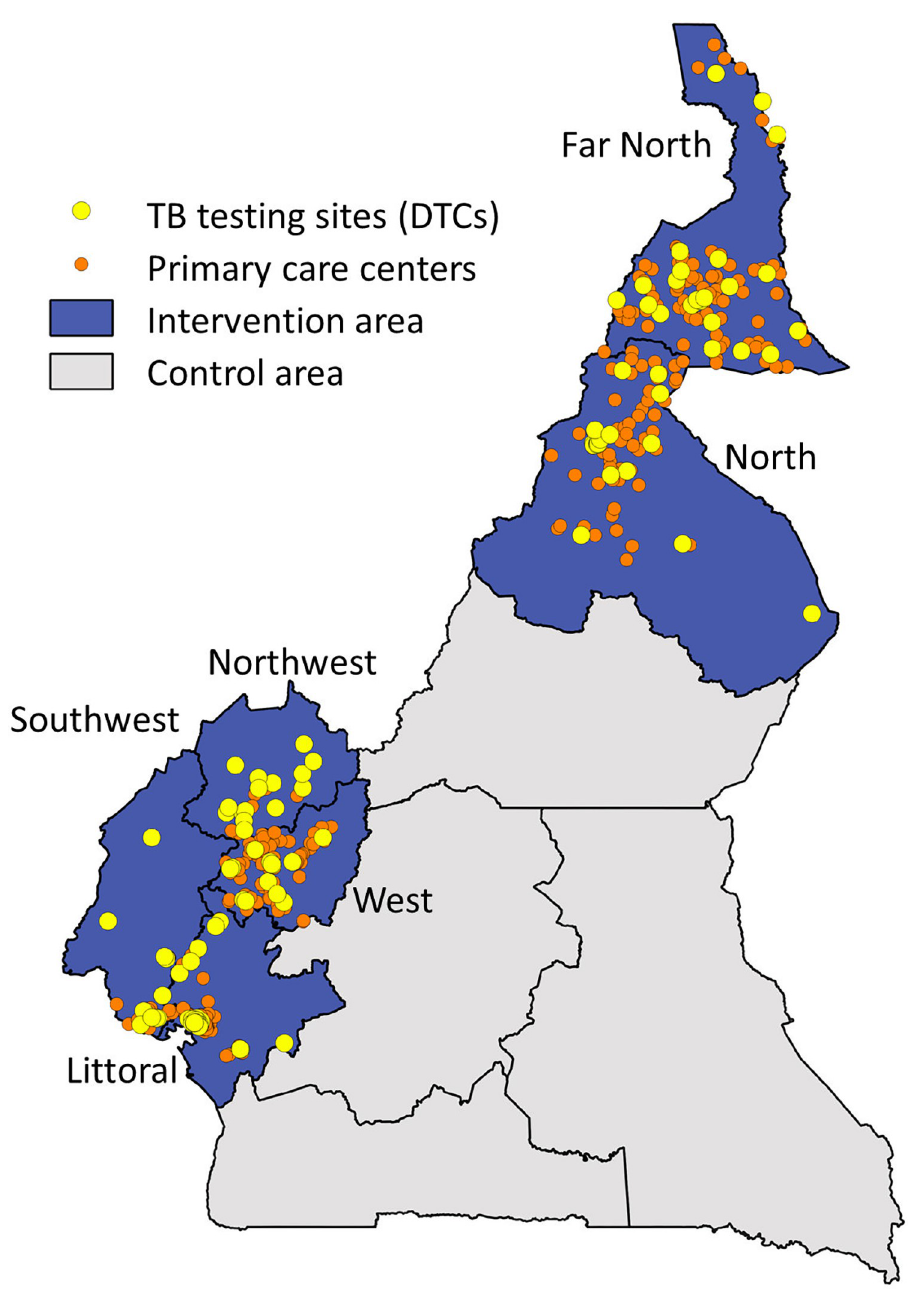
Fig 1. Map of Cameroon showing the intervention area (6 regions: Far North, Littoral, North, Northwest, Southwest, West) and control area (4 regions: Adamawa, Center, East, South). The 117 diagnostic and treatment centers of the National TB Program (NTP) in the intervention area (yellow dots); the 608 primary care centers linked to these TB testing sites (orange dots). (Map source: https://data.humdata.org/dataset/b13f08ef-92ee-4446-9b0a-